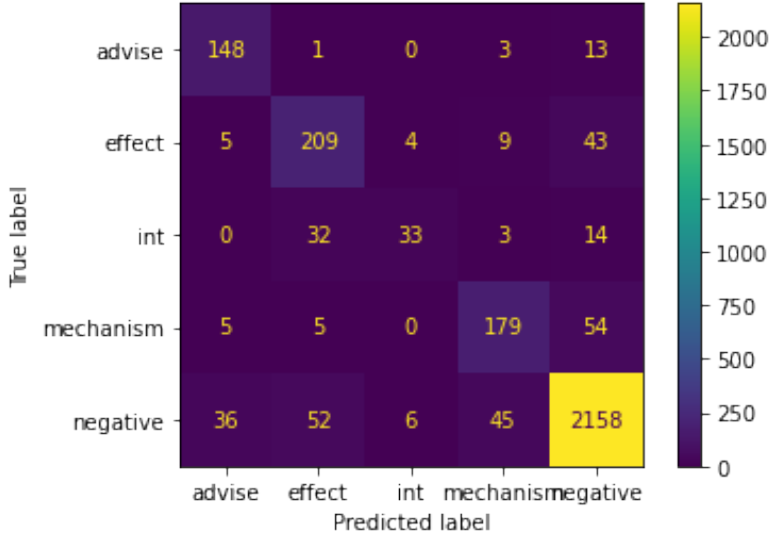
Figure 6. Confusion matrix of our proposed